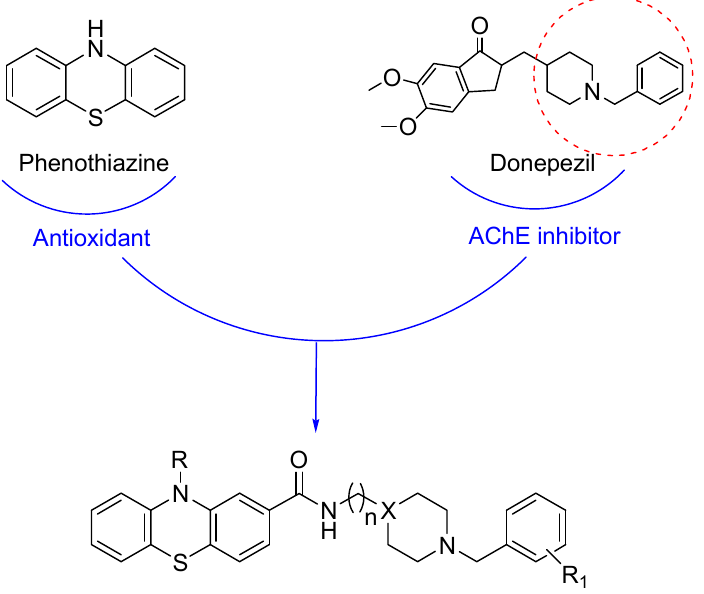
Figure 1. Drug design for the hybrids 11a–e , 12a–e and 13 .